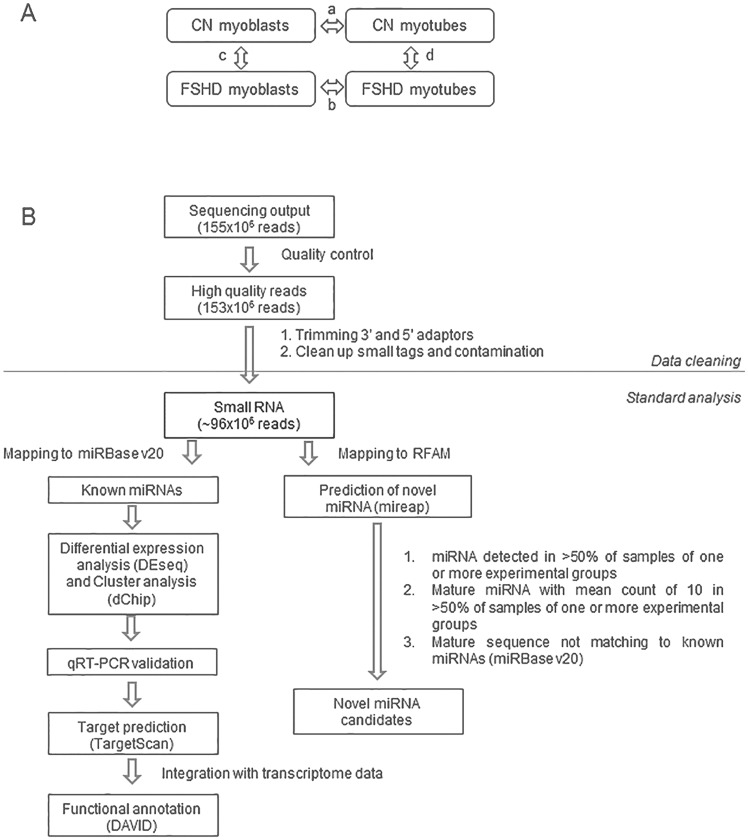
Study design and data analysis.A) Study design: Next-generation Sequencing (NGS) on three control and three FSHD myoblast cell lines before and after in vitro myogenic differentiation was used in order to derive miRNA modulation in: a) control myogenesis (CN myotubes vs CN myoblasts; arrow a); b) FSHD myogenesis (FSHD myotubes vs FSHD myoblasts; arrow b); c) FSHD myoblasts versus control myoblast (arrow c), and d) FSHD myotubes vs control myotubes (arrow d). B) Flow chart of filtering and analysis of NGS data. NGS generated a total of 153×106 high quality reads, that were filtered for rRNA, tRNA, snRNA, snoRNA, repeat associated RNAs and intron/exon. The filtered reads (approx. 99×106 reads, an average of 8×106/sample) were analyzed to derive known miRNAs (R/Bioconductor) and novel miRNAs (mireap). Differentially expressed miRNAs between samples were derived by log2FC≧2 and p-value<0.05 parameters. The homogeneity of miRNA modulation among samples was evaluated by cluster analysis (dChip). miRNAs were then validated by qRT-PCR. Finally, target genes were predicted for modulated miRNAs and functionally annotated by DAVID.